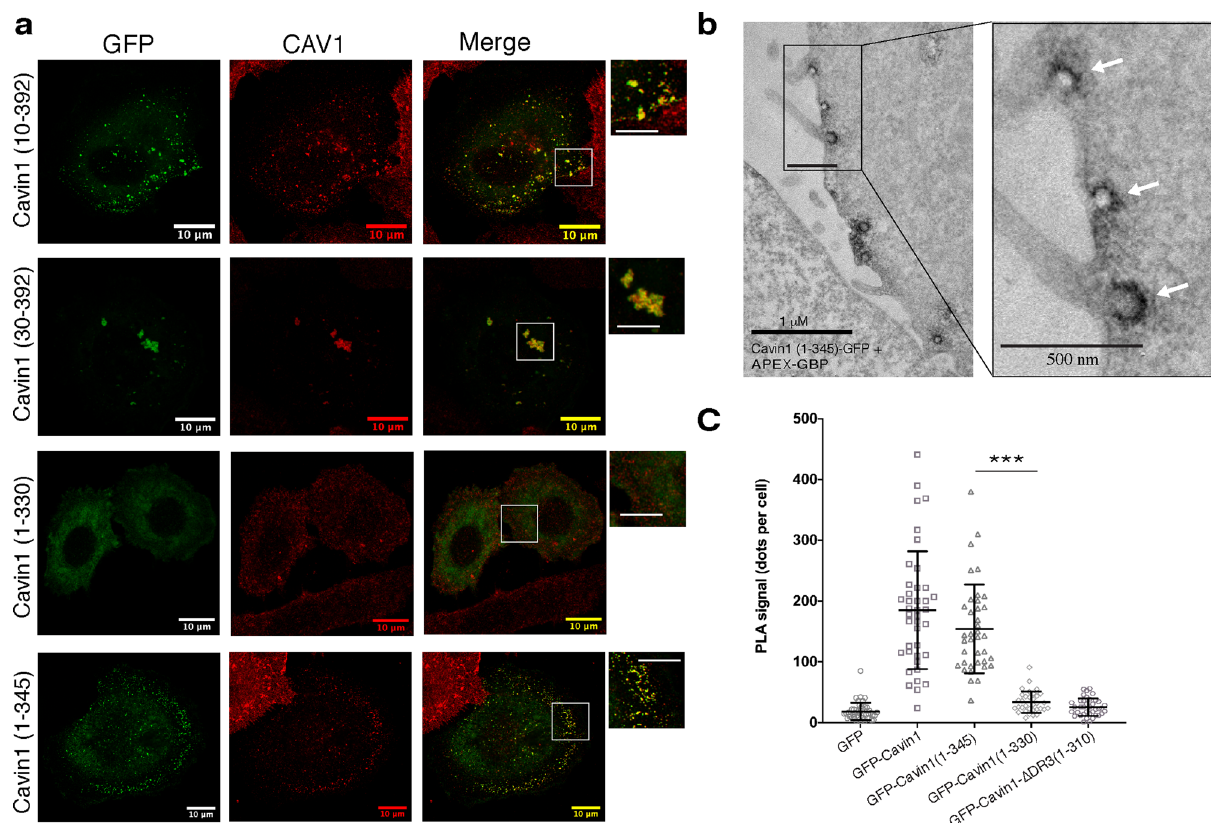
Fig. 7 De fi nition of the minimal DR sequences required for Cavin1 function. a GFP-tagged Cavin1 DR domain truncation mutants (green) (Fig. 4c) were expressed in PC3 cells and immunolabelled with CAV1 (red). Residues 1 – 30 in DR1 and 330 – 345 are required for caveola formation. Scale bar = 10 μ m; enlarged boxes scale bar — 5 μ m. b APEX-GBP labelling of GFP tagged Cavin1(1 – 345) shows normal bulb-shaped caveolae at the plasma membrane. c Proximity ligation assay (PLA) analyses show that truncation of Cavin1 from the C-terminus beyond residue 345 results in loss of association with CAV1. PLA signal was quanti fi ed as dots per cell for speci fi c interaction between GFP-tagged proteins and CAV1, n = 33 over two independent experiments. Error bars indicate mean ± SD, *** P < 0.001. Source data for Fig. 7c are provided as a Source Data fi